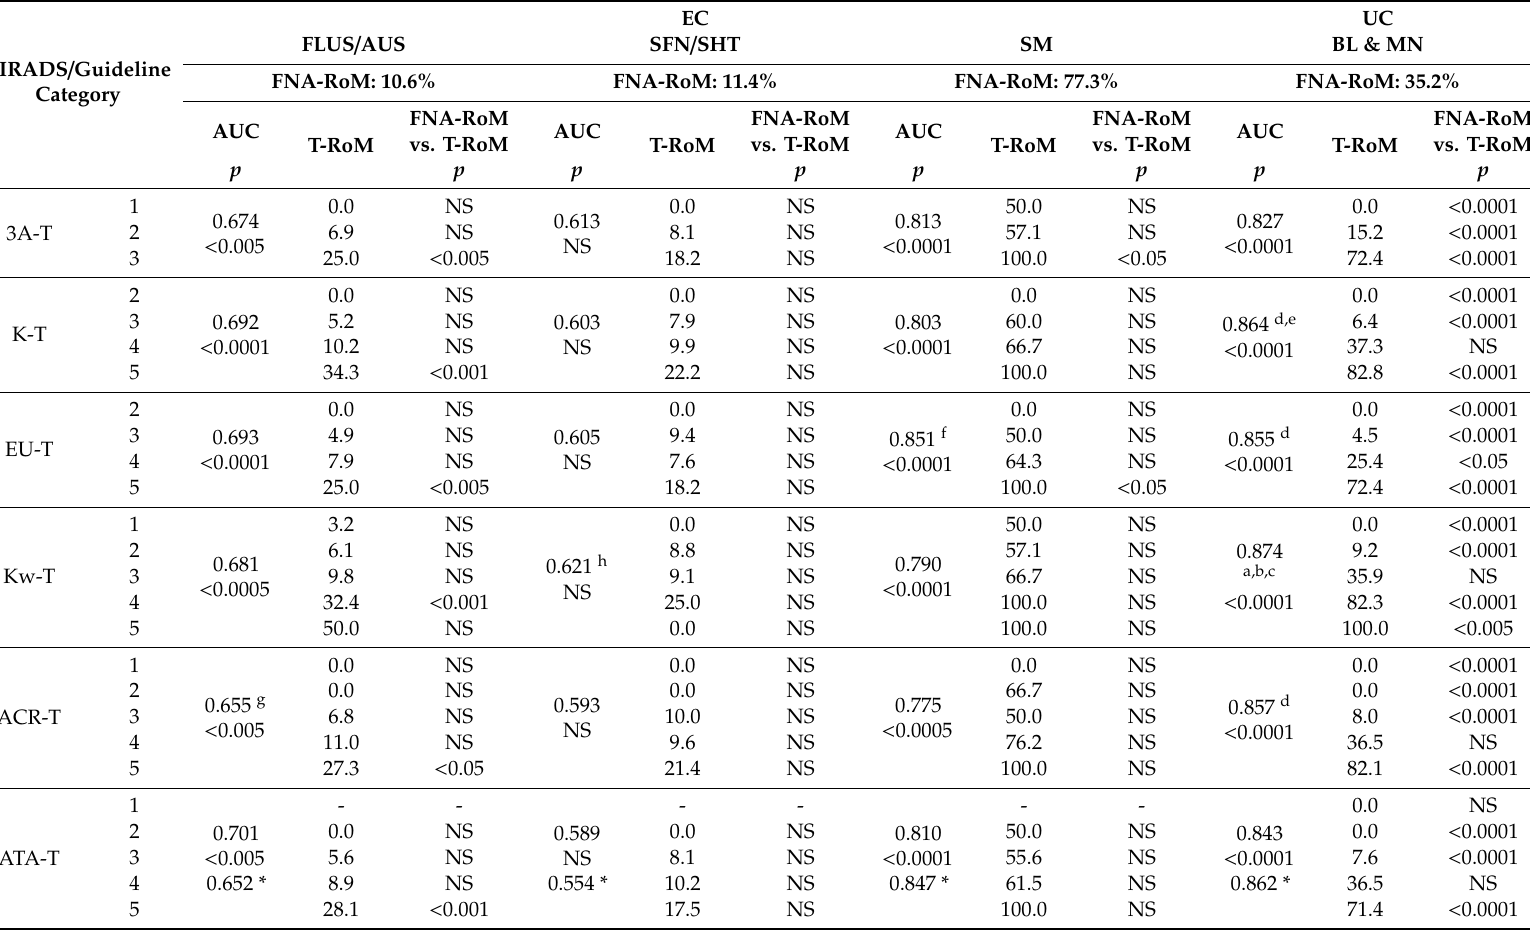
Table 3. Diagnostic e ffi cacy of evaluated TIRADS as measured with AUC in the UC group and subgroups of the EC group; the change from FNA-ROM of a nodule in relation to its TIRADS